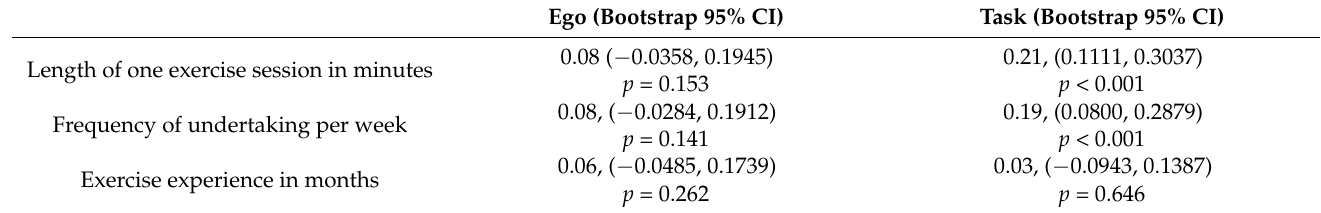
Table 5. Correlations between the ego and the task subscale and studied physical activity components.